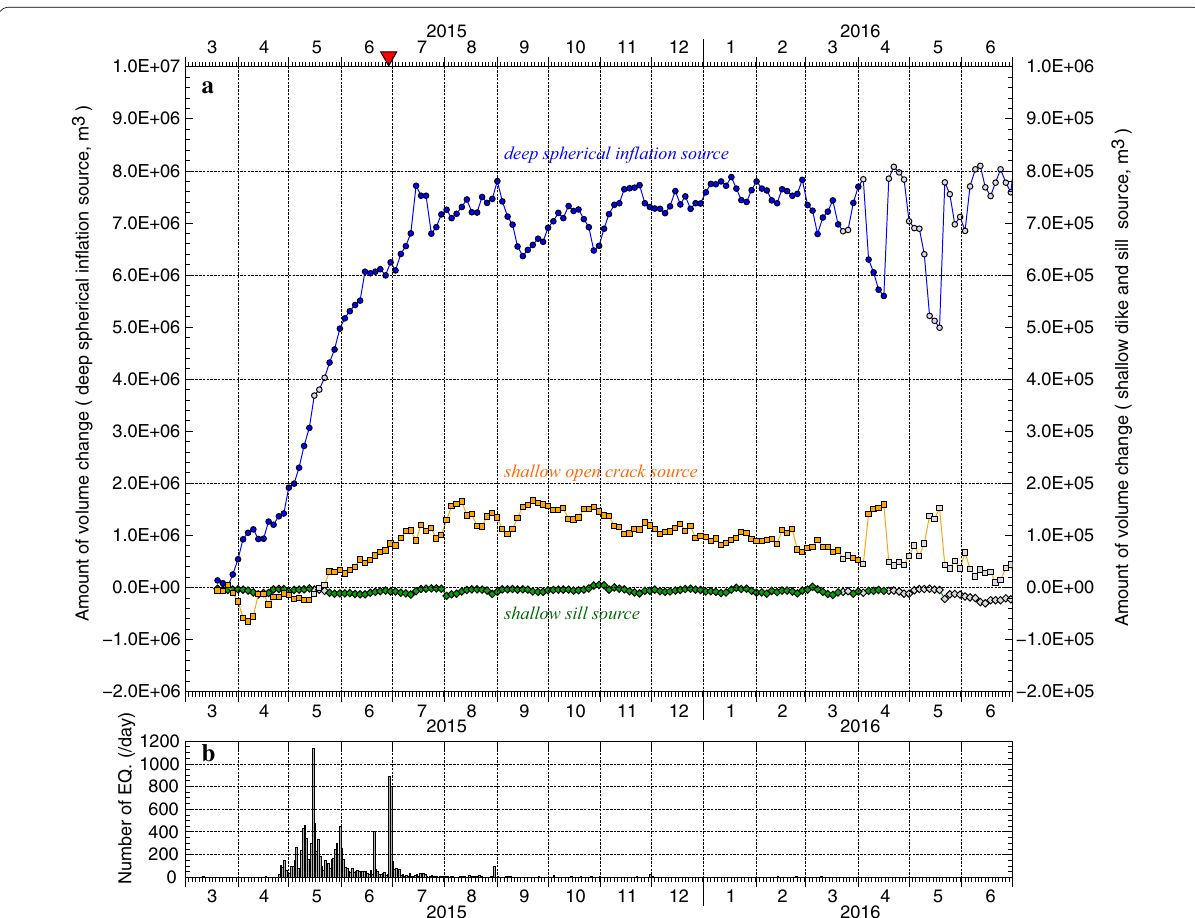
3.0 10 − 3 ). b Daily number of earthquakes at Hakone volcano during the same period as ≥ ×